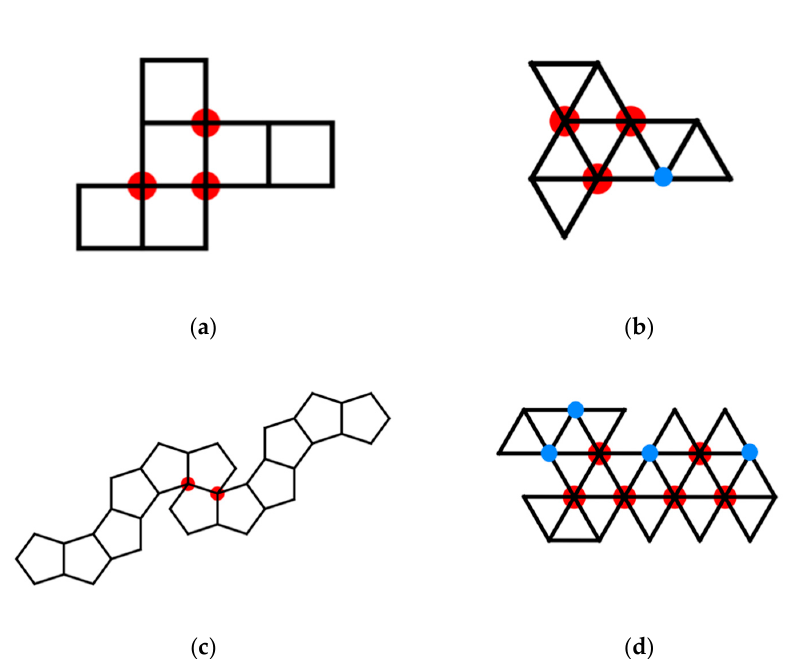
Figure 16. Vertex connections under two different definitions: We prefer the restrictive definition of a vertex connection, shown in red. The traditional definition includes vertices shown in red and blue: ( a ) vertices of degree 4 for Dürer nets of cubes, ( b ) vertices of degree 5 for Dürer nets of octahedra, ( c ) vertices of degree 4 for Dürer nets of dodecahedra, and ( d ) vertices of degree 6 for Dürer nets of icosahedra. We do not think including vertices of degree 4 for Dürer nets of octahedra or vertices of degree 5 for Dürer nets of icosahedra are informative for folding potential.